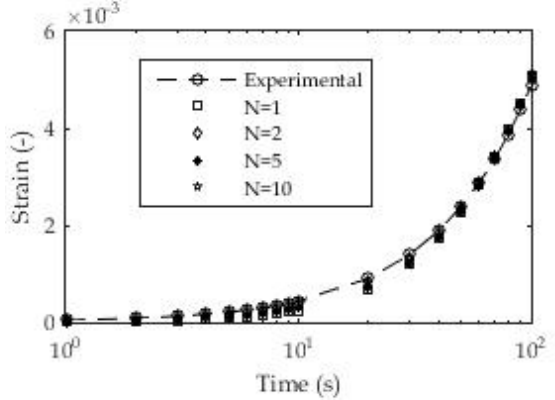
Figure 9. Experimental and fitted values of strain (ABS, d = 0.19 mm).